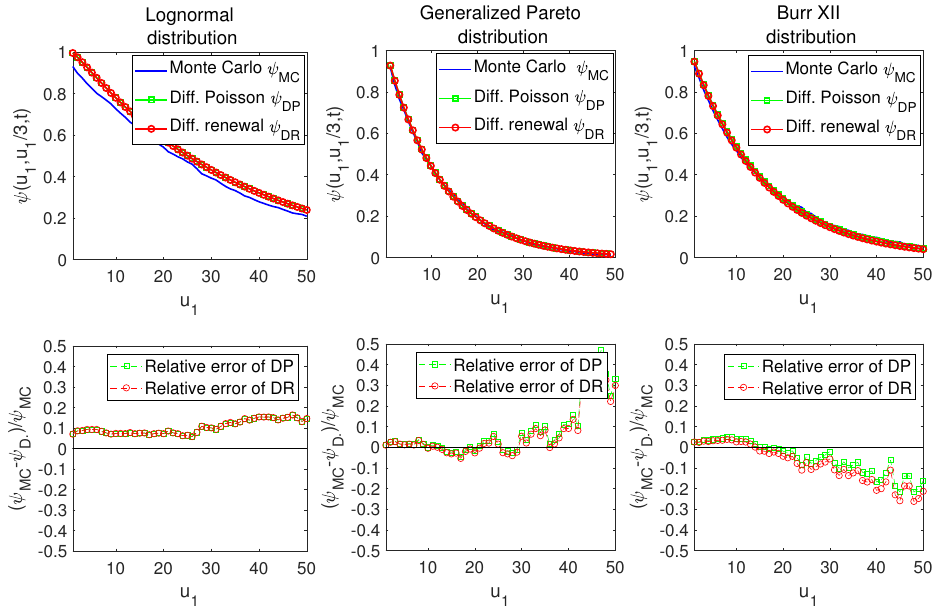
Figure 2. Ruin probabilities ( top panels) for the insurer–reinsurer model in the finite-time horizon calculated using Monte Carlo (MC) simulations with the renewal process with α = 10, σ M = 0.1, the diffusion approximation with the Poisson process (DP) with λ = 10 and the diffusion approximation with the renewal process (DR) for selected heavy-tailed distributions. Respective relative errors ( bottom panels) of the approximations. In the simulations t = 100, number of MC iterations is 10,000, parameters of claim distributions are given by Equations (21)–(23).